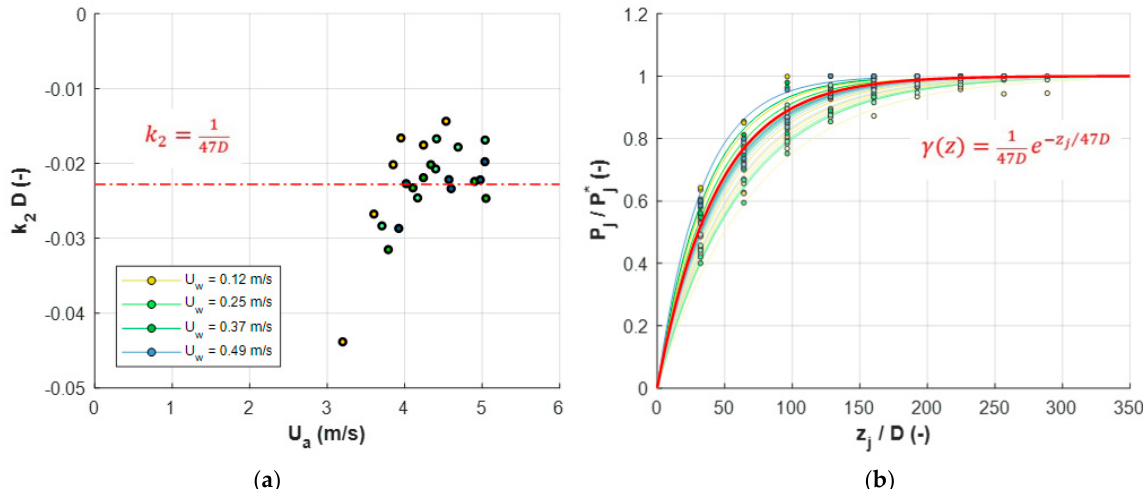
Figure 7. ( a ) Empirical product k 2 D plotted as a function of normalized velocity U a and ( b ) normalized junction contribution data, P j /P j* , achieved with the mean coefficient value k 2 =